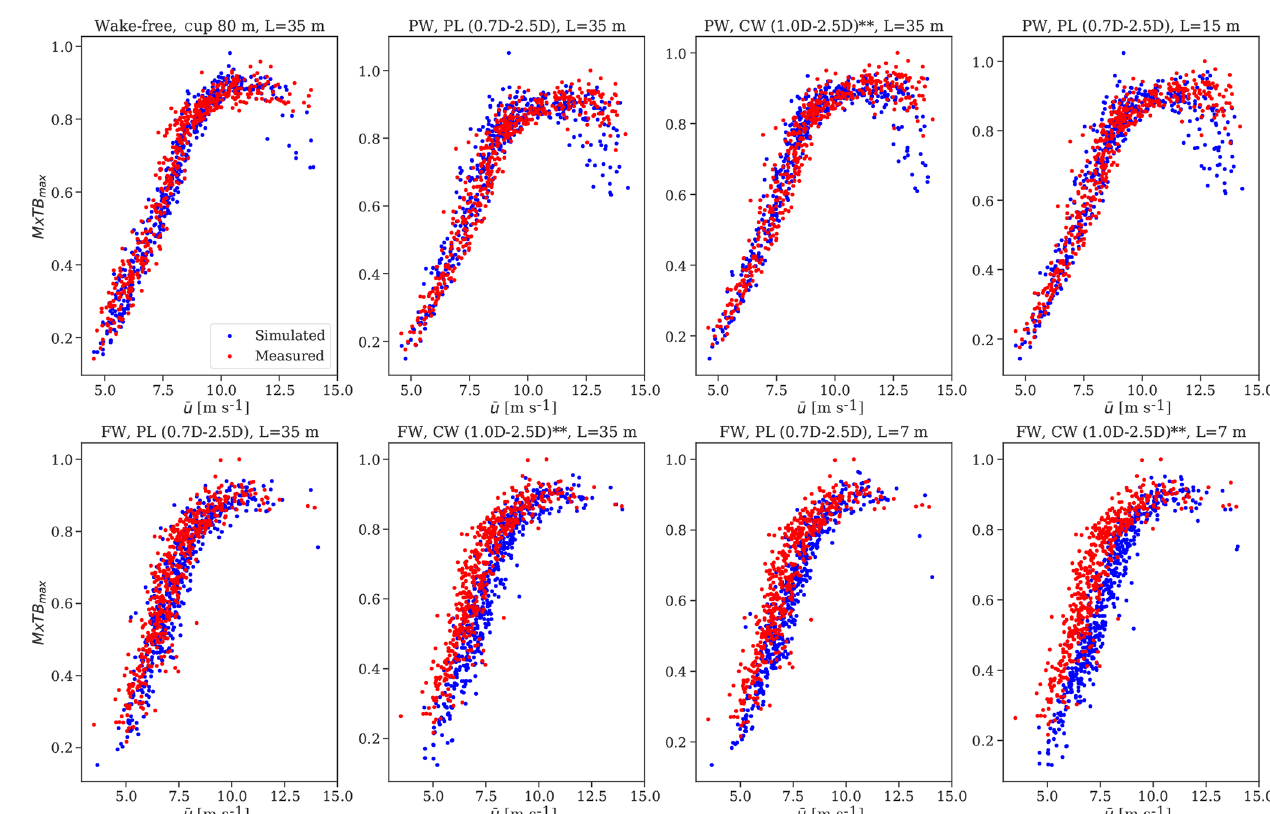
Figure C2. Scatter plots of the normalized measured and predicted extreme fore–aft tower bottom bending moment realizations used in the